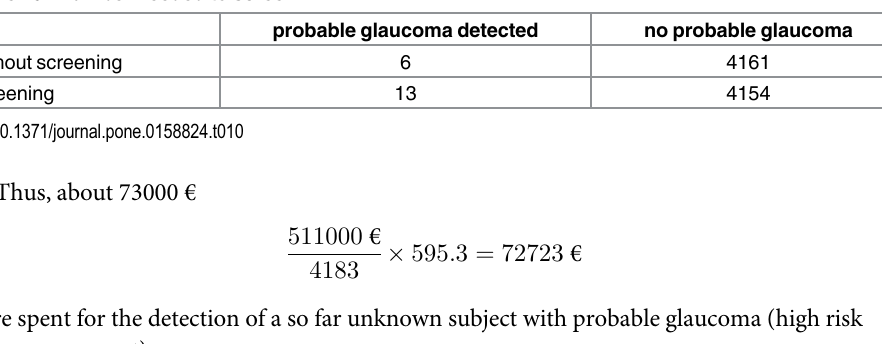
Table 10. Number needed to screen.